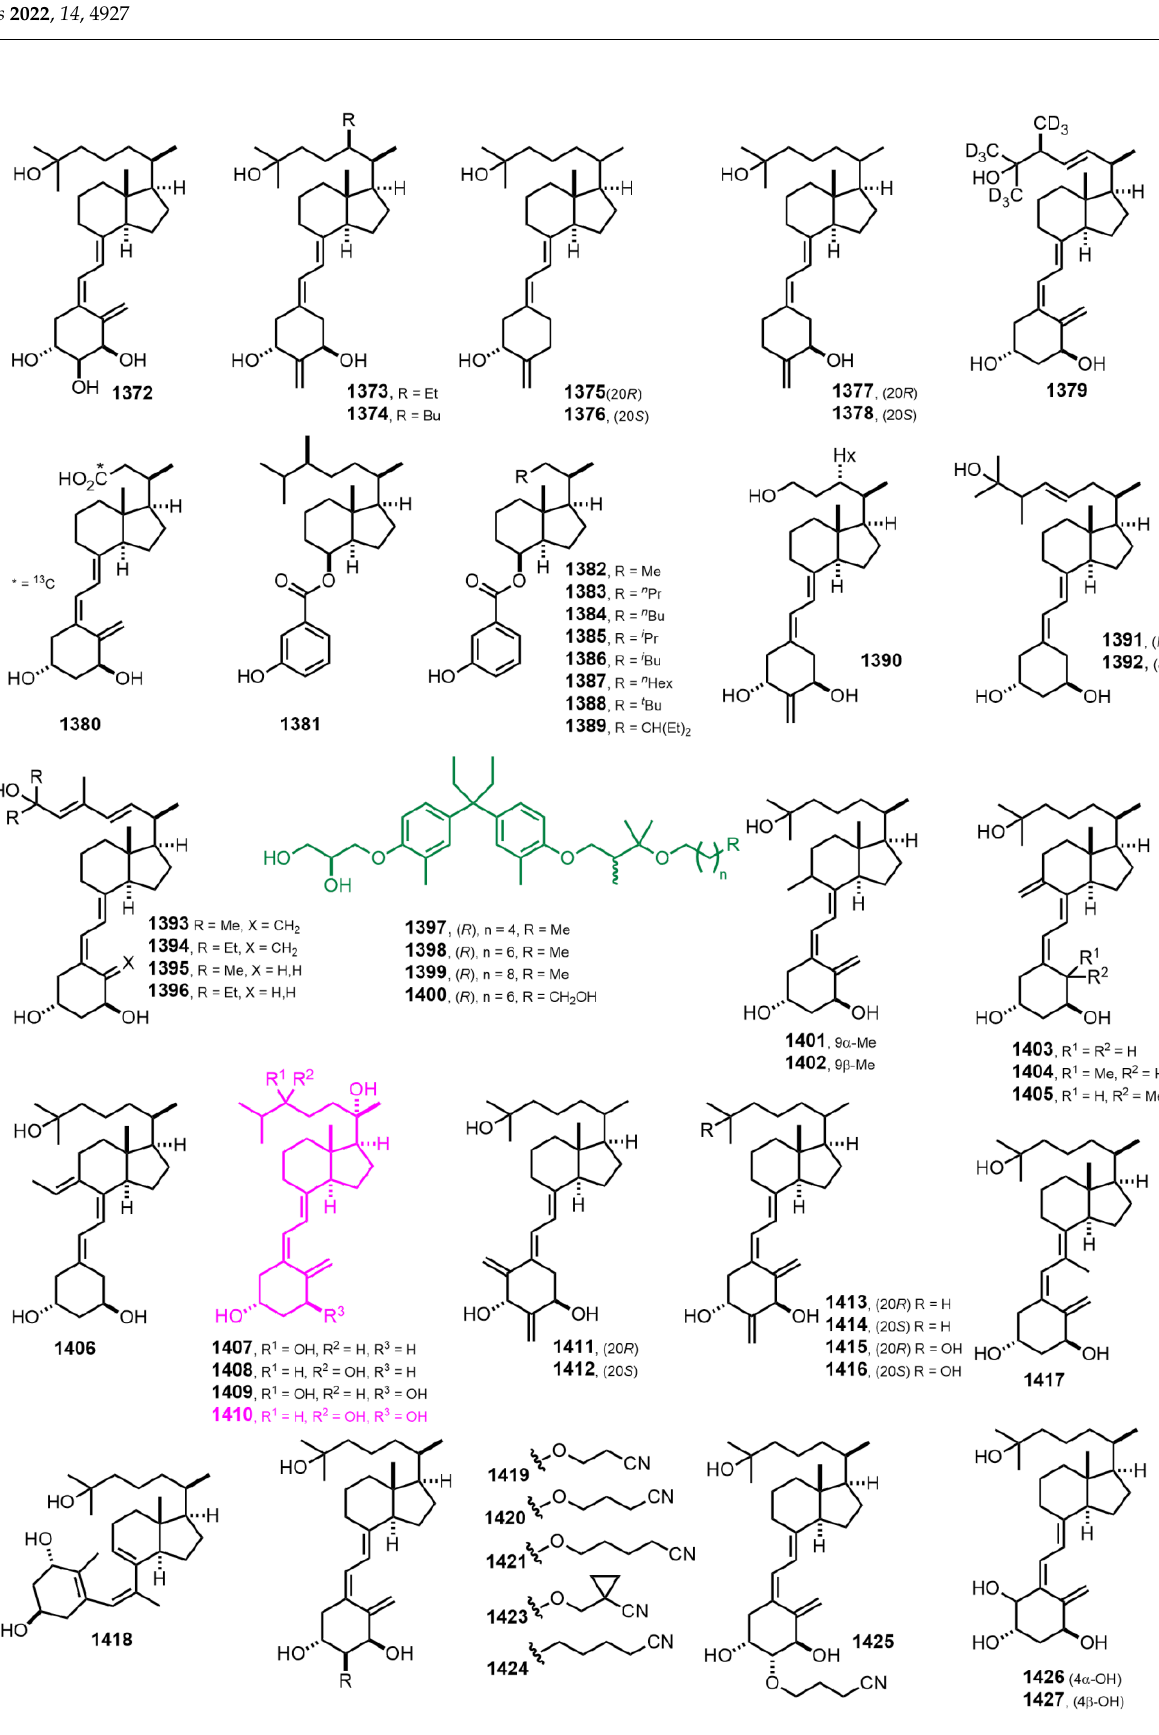
Figure 24. (2014-2015) [322 – 336].